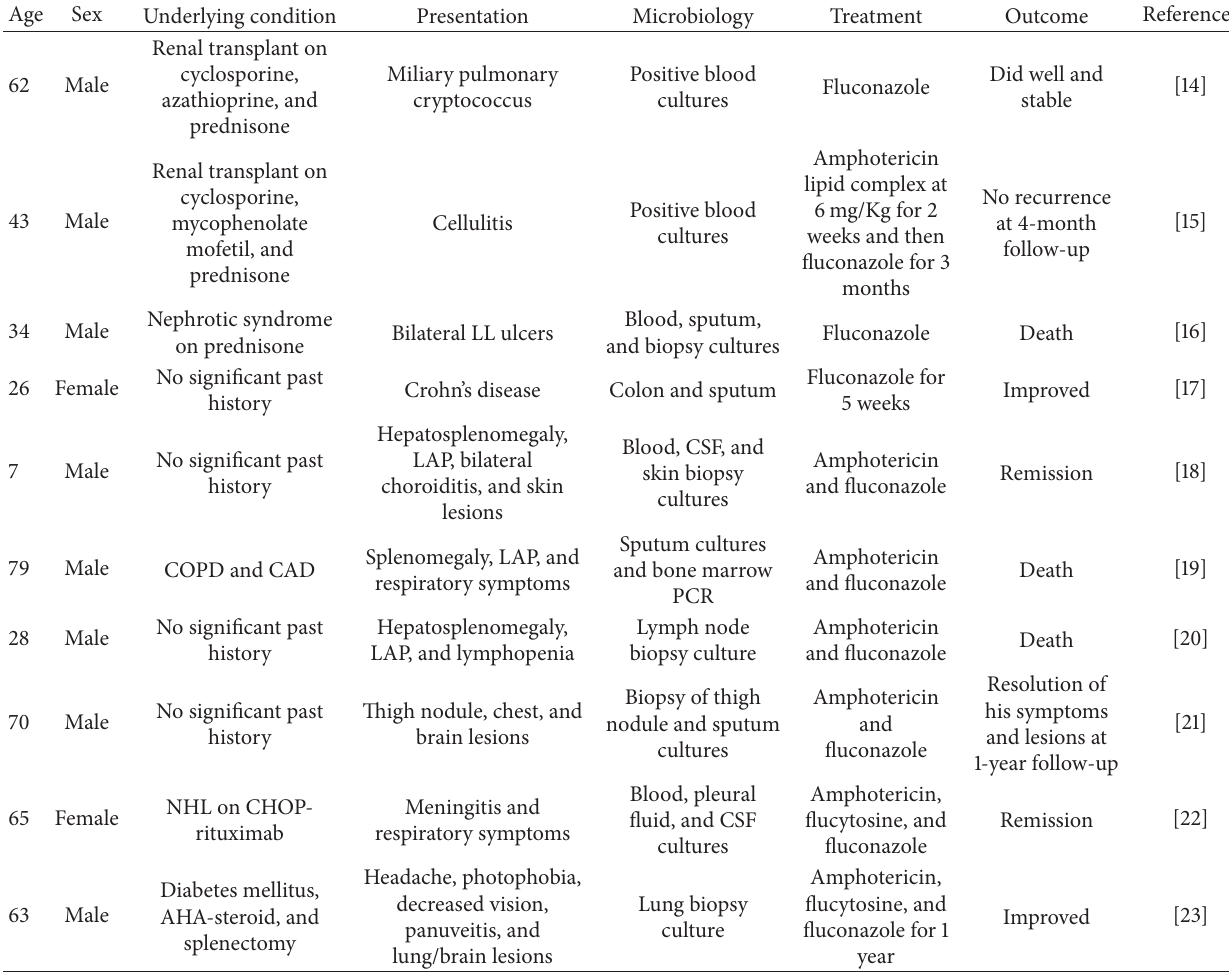
Table 2: Review of HIV negative disseminated cryptococcal case